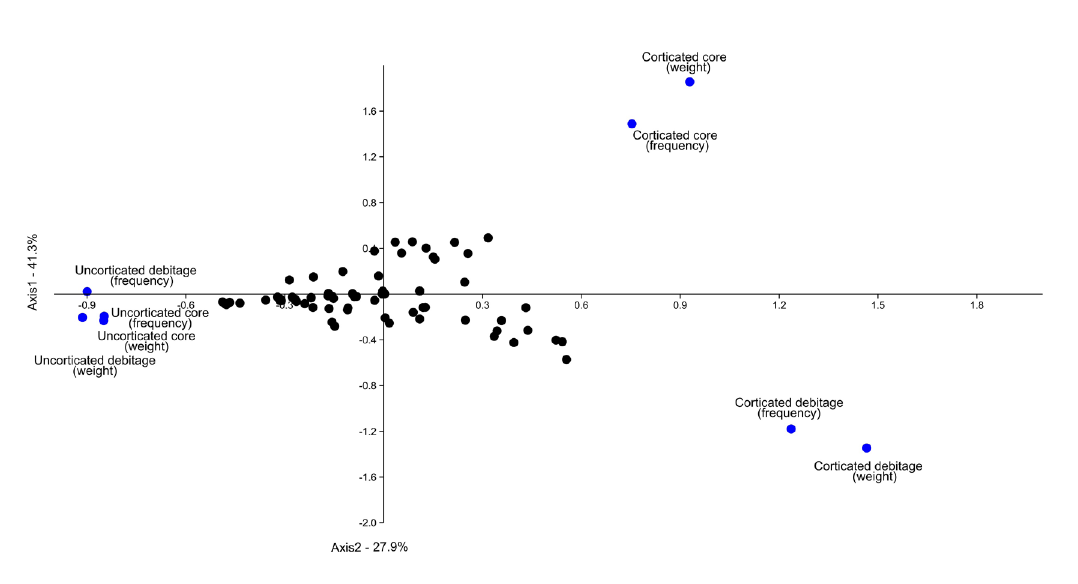
Figure 7: Correspondence analysis of Mezőzombor type limnosilicite and the plot according to the first and second